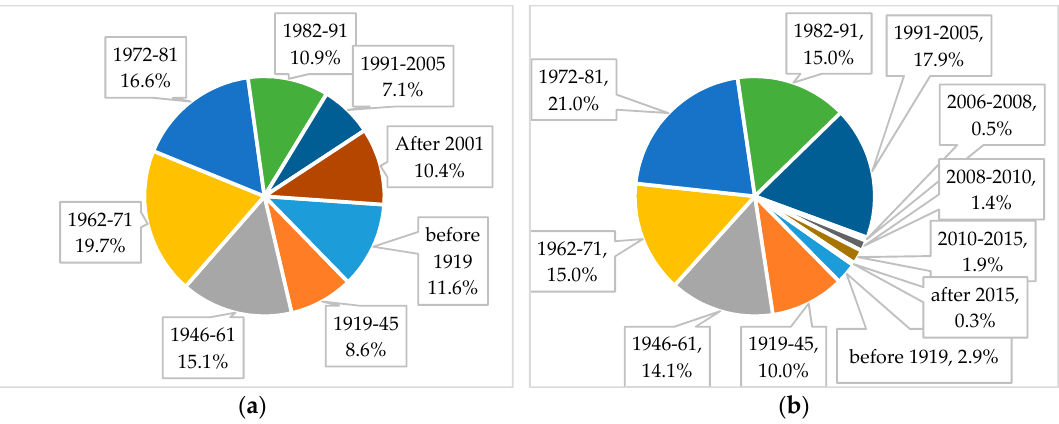
Figure 3. Buildings’ subdivision sorted by the construction age: ( a ) Italian stock; ( b ) sample buildings.